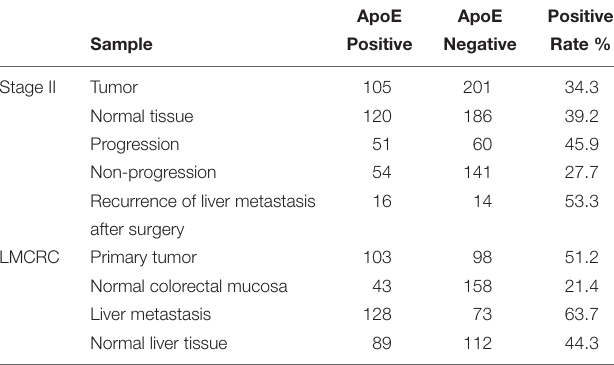
Stage II, stage II colorectal cancer; LMCRC, liver metastatic colorectal cancer; Progression, tumor recurrence after surgery in 5 years; Non-Progression,